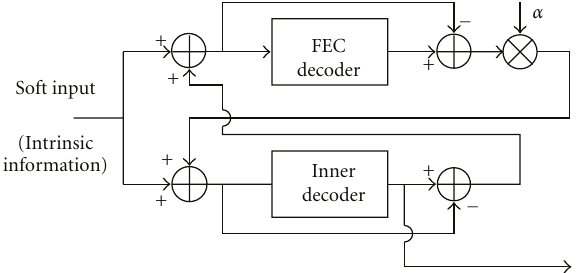
Figure 2: SISO turbo product code decoding